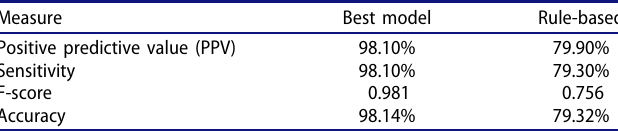
Table 6. Statistical measures of the best model and the rule-based model.